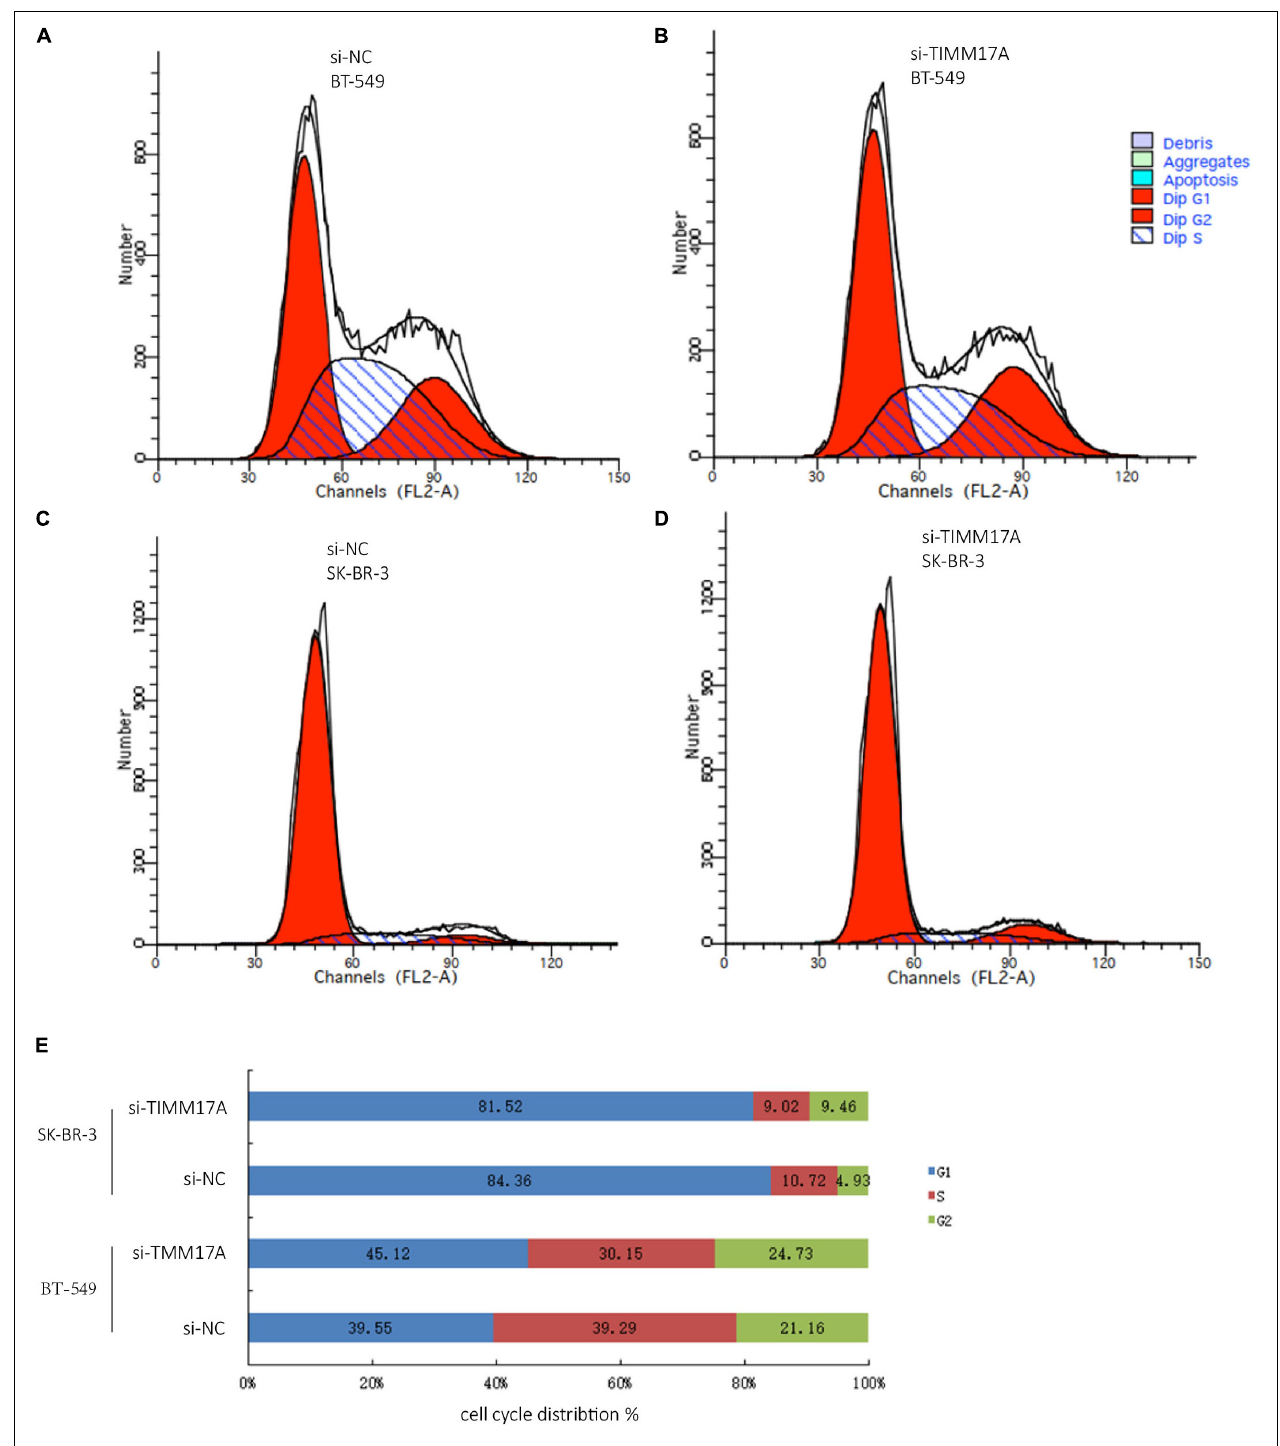
FIGURE 8 | Cell cycle analysis of BRCA cells. (A) Cell cycle analysis of BT-549 cells by flow cytometry. (B) Cell cycle analysis of TIMM17A knockdown BT-549 cells by flow cytometry. (C) Cell cycle analysis of SK-BR-3 cells by flow cytometry. (D) Cell cycle analysis of TIMM17A knockdown SK-BR-3 cells by flow cytometry. (E) Cell cycle distribution of siRNA-SK-BR-3, NC-SK-BR-3, siRNA-BT-549 and NC-BT-549.